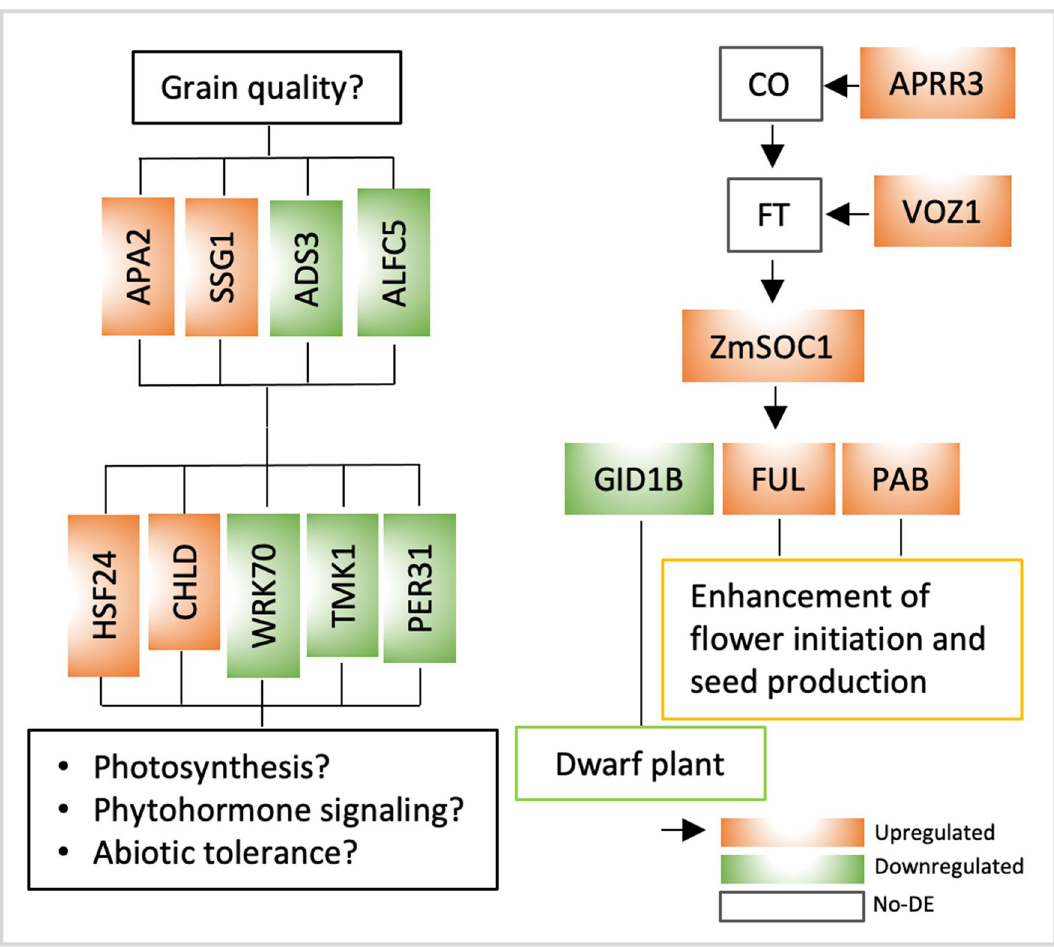
Figure 6. Potential effects of the expression of the ZmSOC1 on soybean plant growth and development revealed by the shared differential expressed genes (DEGs) identified in leaves of two transgenic lines (i.e., #20tr and #60tr) (Table